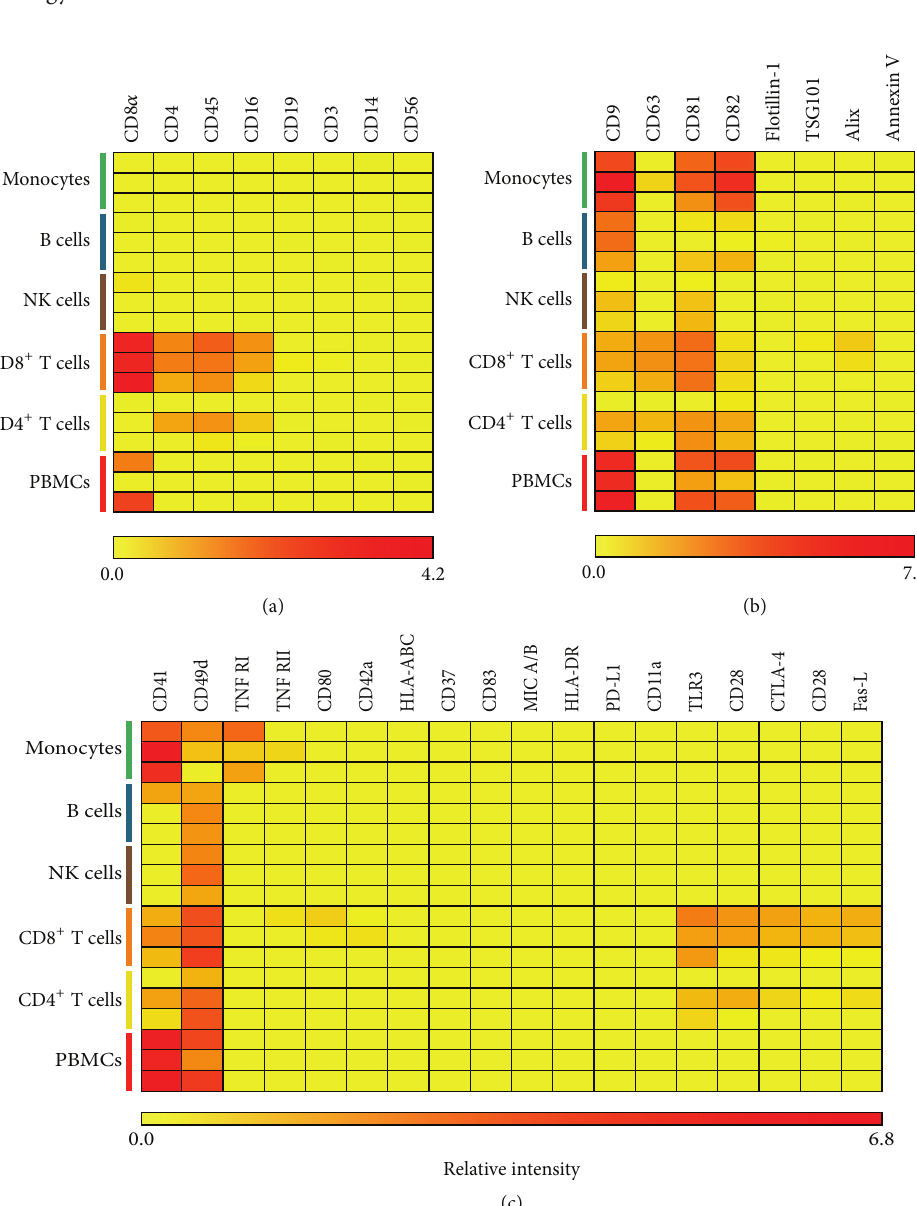
for the monocytes that presented high levels of CD63